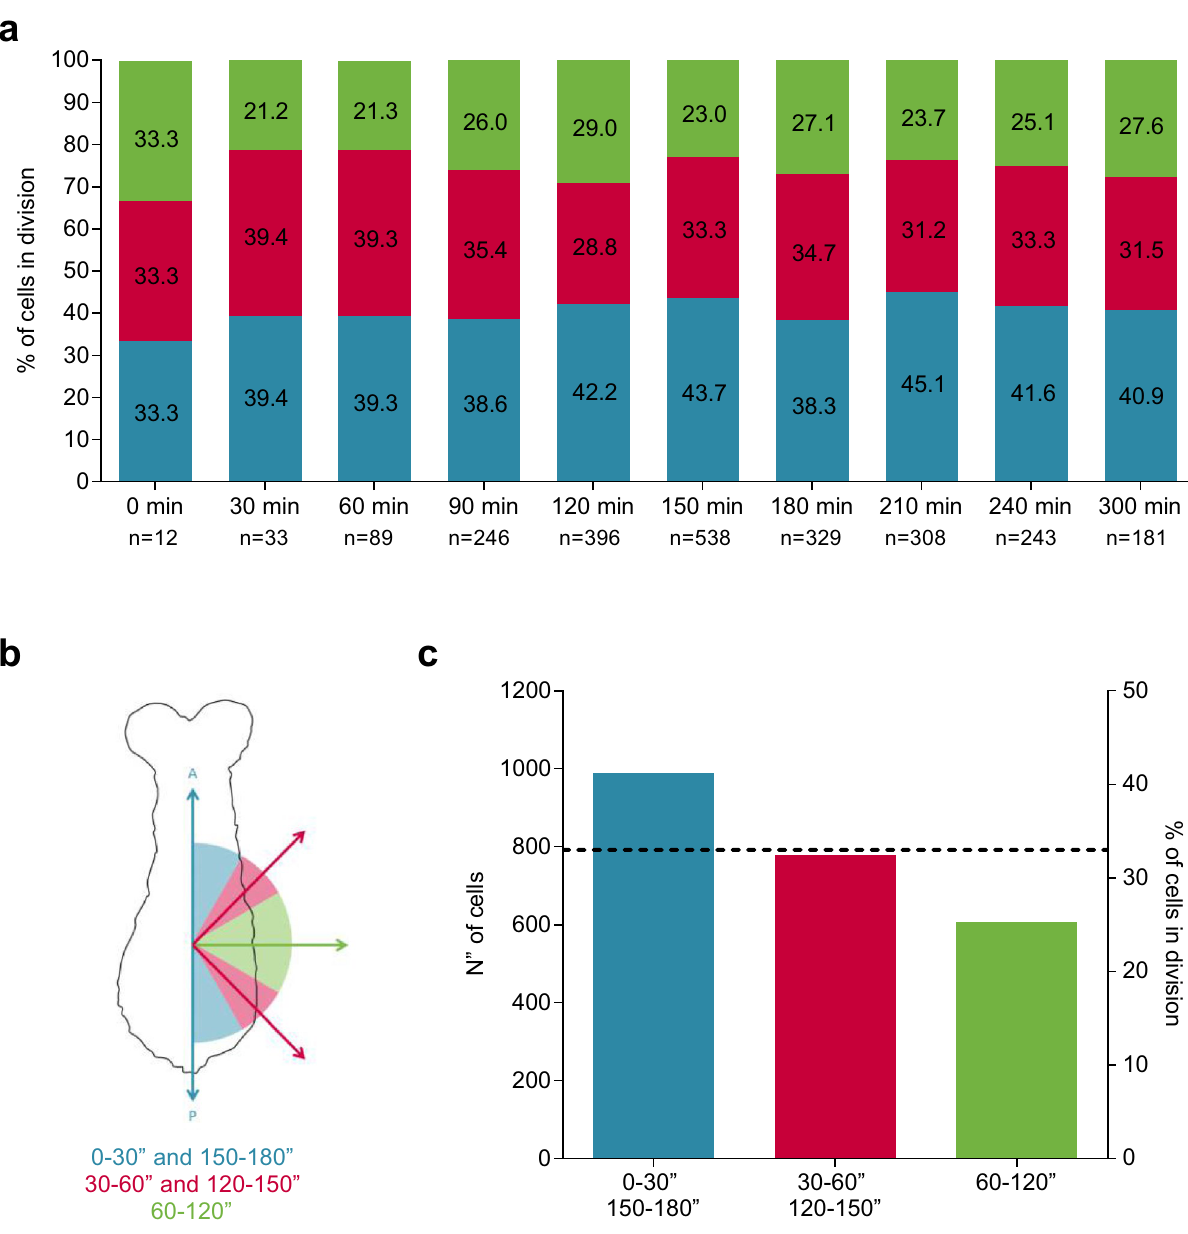
Figure 5. Cell division orientation has an anterior–posterior contribution to germband extension. ( a ) Percentage distribution of mitotic angles relative to the anterior–posterior axis (elongation axis) by stage and total distribution. Number of cells analyzed (n) is also shown. ( b ) Schematic diagram of a Tribolium germband showing the angle selection criteria and the color code. Blue: Mitotic angles between 0°–30° and 150°–180°; Red: 30°–60° and 120°–150°; Green: 60°–120°. ( c ) Total distribution analysis of cell division angles. The broken line represents the expected percentage if random cell divisions are present during elongation (~ 33%). The bars represent the amount of dividing cells that showed the corresponding angle range. Each group was analyzed by the Chi-square test of homogeneity, showing that the orientations were not distributed equally ( p < 2.2 × 10 –16